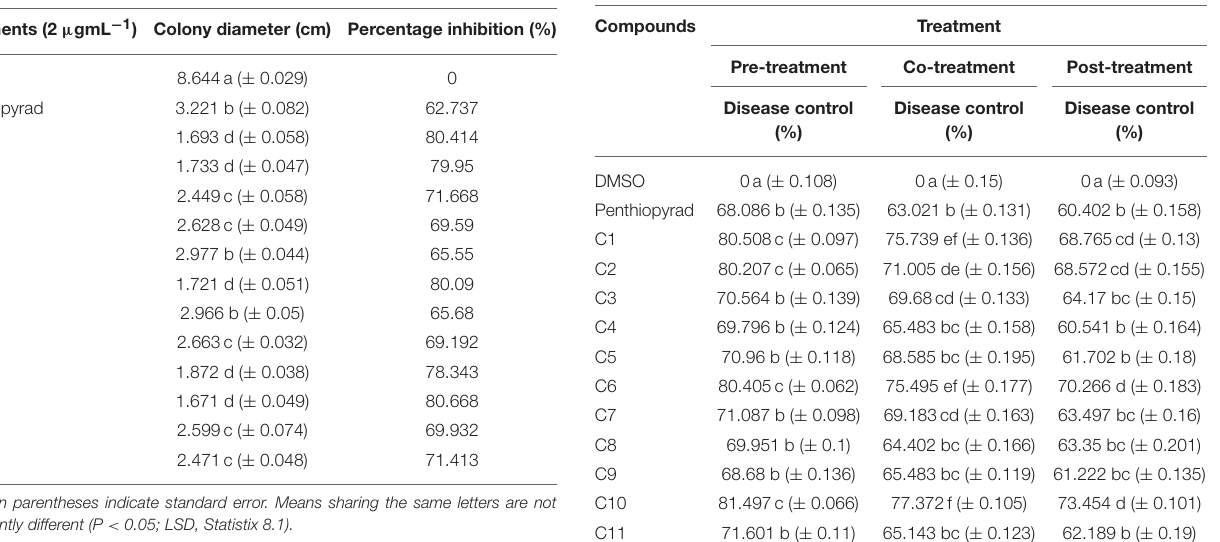
TABLE 1 | In Vitro antifungal potential of SDHIs against A. solani as assessed through agar diffusion assay.